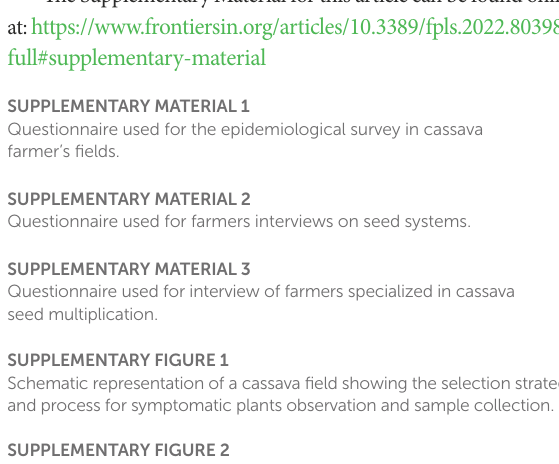
SUPPLEMENTARY FIGURE 1 Schematic representation of a cassava field showing the selection strategy and process for symptomatic plants observation and sample collection. SUPPLEMENTARY FIGURE 2 Results from molecular detection showing the agarose gel with amplicons: Detection of CBSV (~703 bp) and UCBSV (~800 bp) in samples from the site 1 (1 and 6), site 2 (2 and 7), site 3 (3 and 8), site 4 (4, 5 and 9) and site 5 (10, 11 and 12). 1 kb molecular ladder (L) is shown on the left side of the gel. Positive (C+) and negative controls (C-). Numbers 1 to 12 are representative samples retained for the illustration. SUPPLEMENTARY FIGURE 3 Geographical mapping of results from molecular detection. SUPPLEMENTARY TABLE 1 Proportion of fields grown by different types of cutting pathways and means employed by farmers to obtain cuttings across clusters. SUPPLEMENTARY TABLE 2 Number of fields grown by improved as well as local cassava varieties identified in each cluster. SUPPLEMENTARY TABLE 3 Proportion of healthy and infected fields for each type of infection according to the channels used to obtain